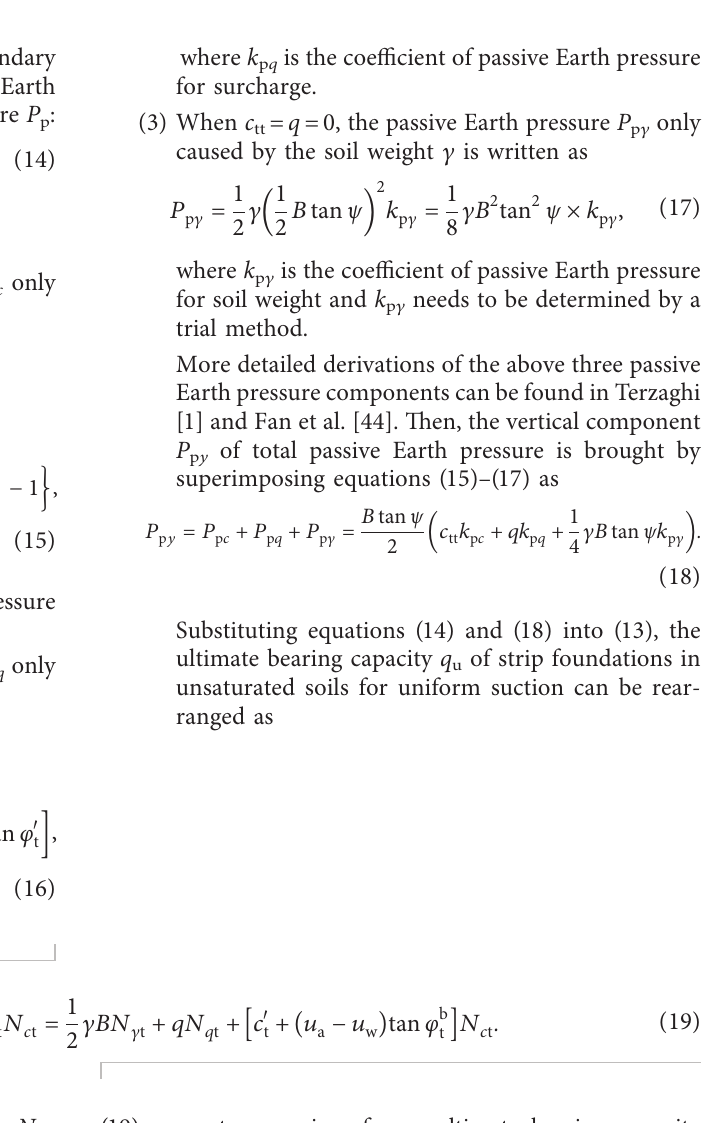
Figure 3: Failure mode of strip foundations based on Terzaghi’s